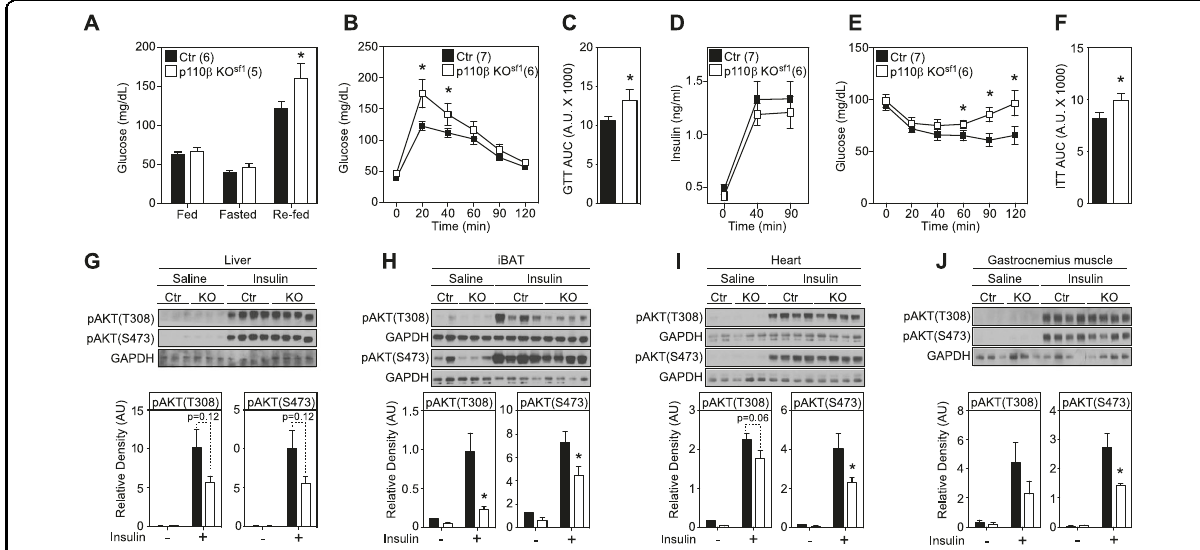
Fig. 2 Deletion of p110 β in SF-1 neurons disrupts glucose and insulin homeostasis. a Glucose levels in fed (3 h fasted), fasted (24 h), and refed (1 h) male mice. b GTT [signi fi cant interaction (two-way repeated ANOVA, F 5.62 = 37.65, p < 0.0001)]. c Area under the curve (AUC) from b . d Insulin levels during the GTT. e ITT [signi fi cant interaction (two-way repeated ANOVA, F 1.66 = 14.84, p = 0.00003)]. f Area under the curve (AUC) from e . Blunted insulin-induced pAKT activation in the g liver, h iBAT, i heart, and j gastrocnemius muscle of p110 β KO sf1 mice. Number of mice in each group is indicated in the legends or directly in the fi gures. Data are shown as the mean ± SEM. * P < 0.05 by Student ’ s t